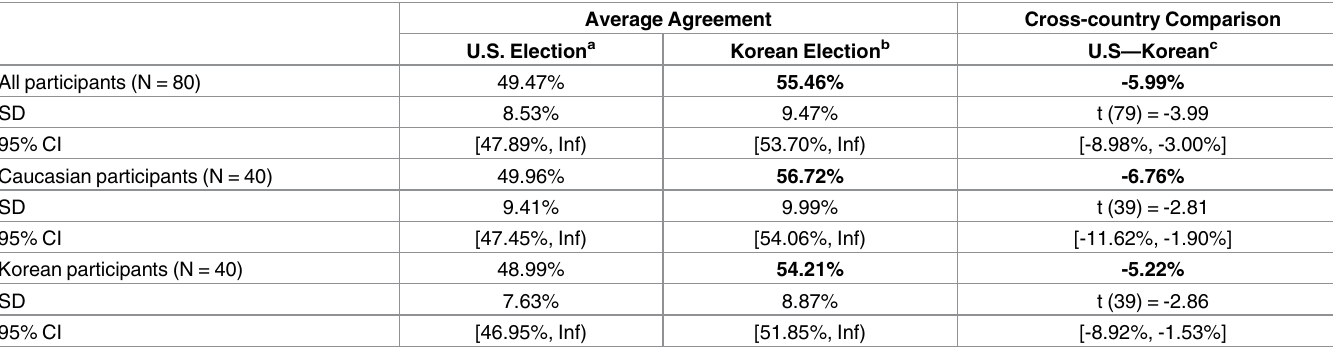
Table 3. Associations between real election outcomes and face-based inferences of